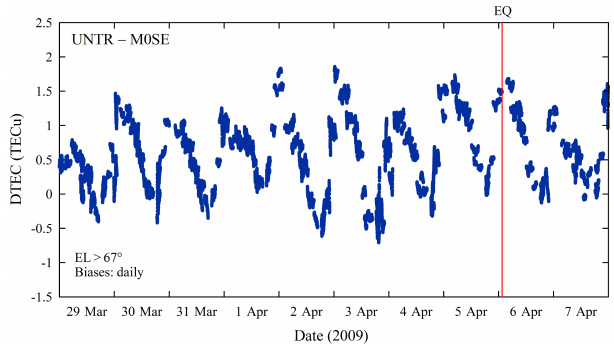
Figure 4. VTEC difference DTEC = TEC UNTR − TEC M0SE be- tween UNTR and M0SE GPS receivers calculated using the same GPS data of Nenovski et al. (2015) from all satellites crossing cen- tral Italy with an elevation angle greater than 67 ◦ . The vertical red line identifies the 6 April 2009 main shock. Hump-like shapes like that reported during 5–6 April by Nenovski et al. (2015) can be seen as diurnal variation in DTEC time series. The vertical red line identifies the 6 April 2009 main shock.